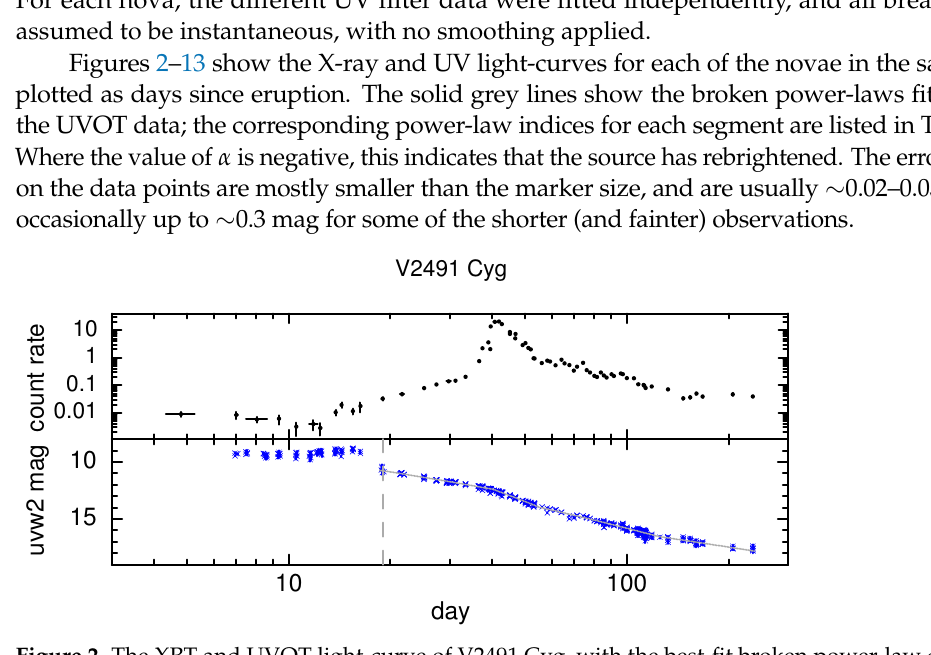
Figure 2. The XRT and UVOT light-curve of V2491 Cyg, with the best-fit broken power-law decline shown as the grey solid line. The UV light-curve shows a rebrightening ‘cusp’ after day 12, so only the data after day 19 (marked with the vertical dashed line) were fitted. The X-ray data (top) are in count s − 1 over 0.3–10 keV.